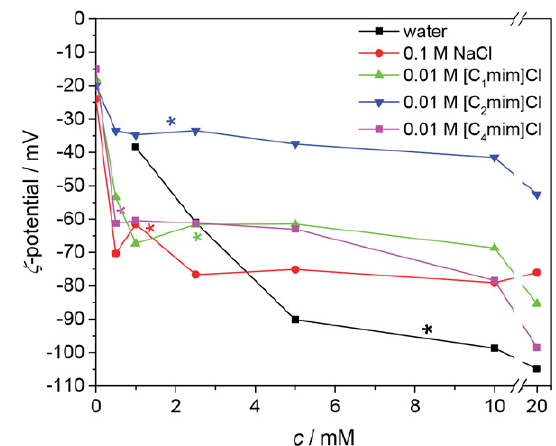
Figure 3. ζ -potential values for all investigated systems as a function of SDS concentration at 298.15 K. Asterisks denote the correspond- ing cmc